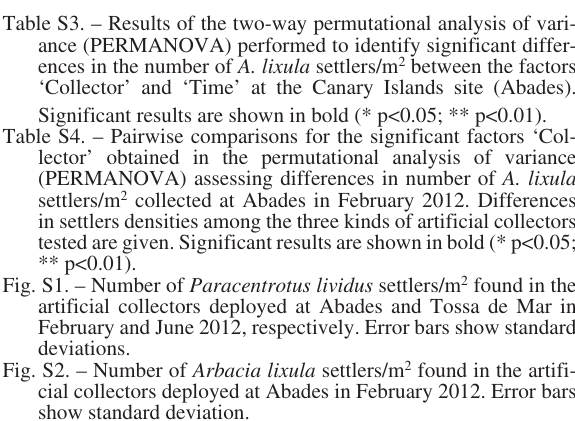
Fig. S1. – Number of Paracentrotus lividus settlers/m 2 found in the artificial collectors deployed at Abades and Tossa de Mar in February and June 2012, respectively. Error bars show standard deviations. Fig. S2. – Number of Arbacia lixula settlers/m 2 found in the artifi- cial collectors deployed at Abades in February 2012. Error bars show standard